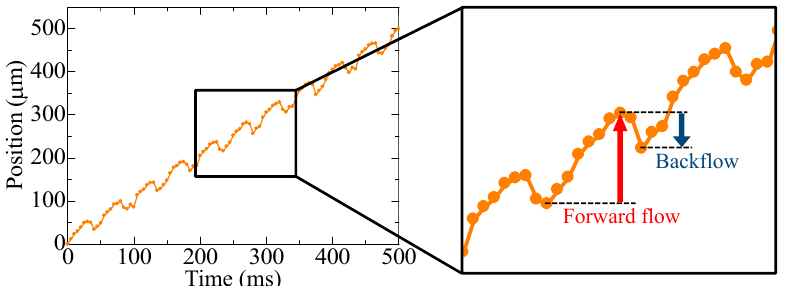
Figure 6. Bead position when driving a single pump, and forward flow and backflow in one